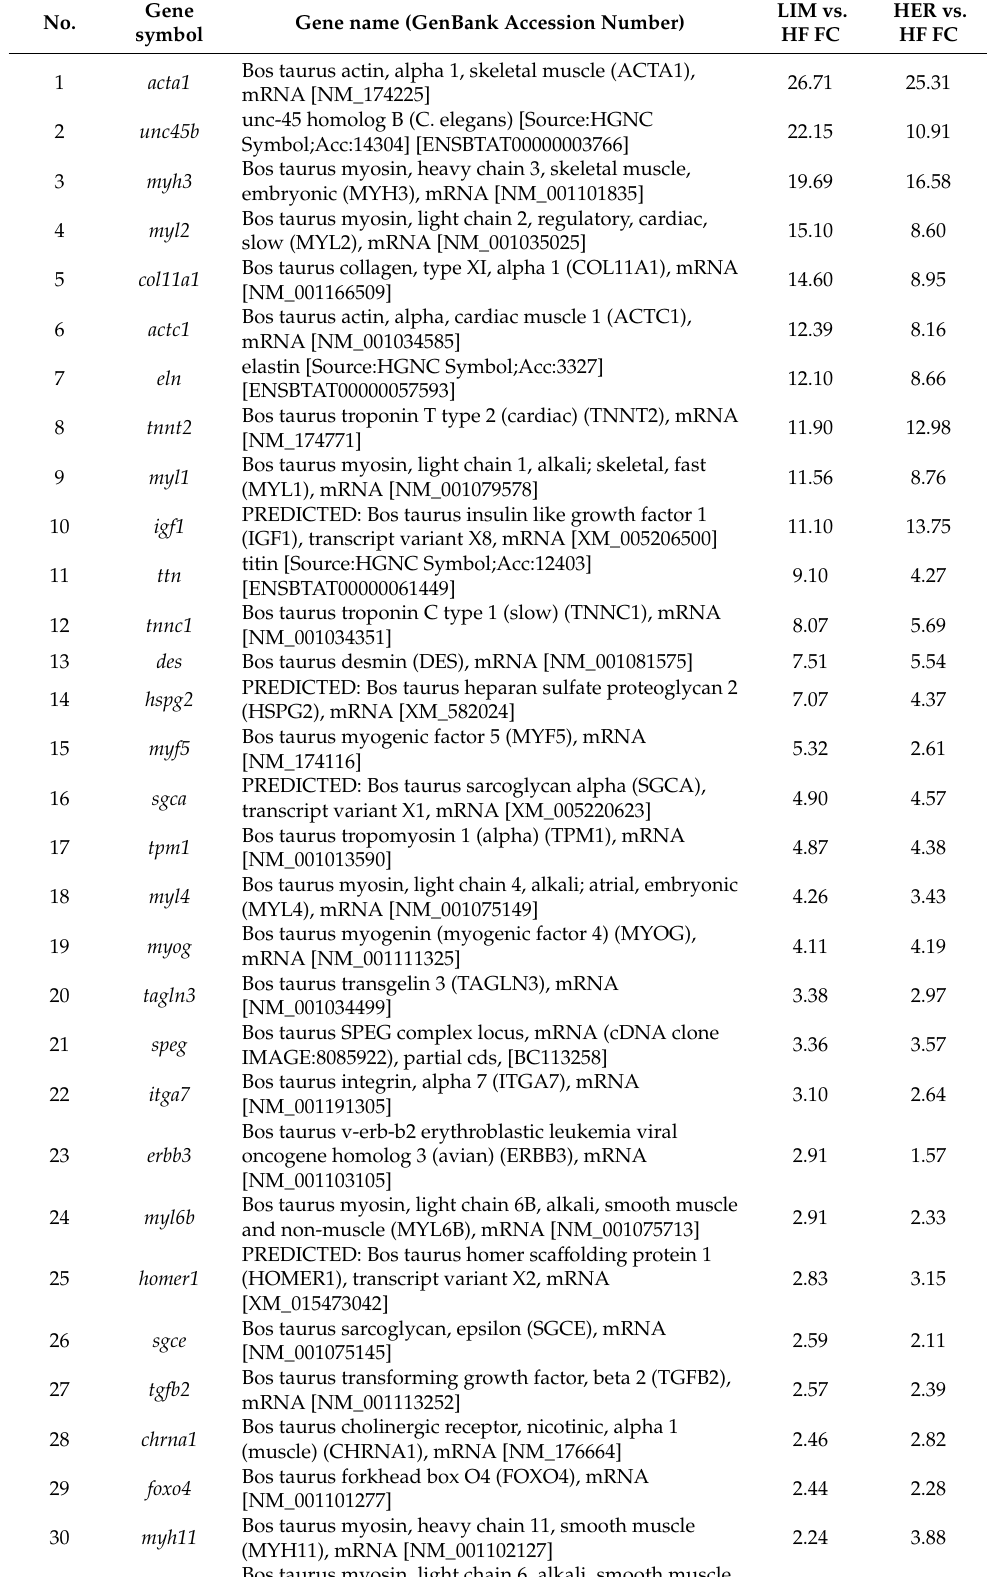
Table 1. List of identified common genes associated with muscle organ development (Database for Annotation, Visualization, and Integrated Discovery— DAVID